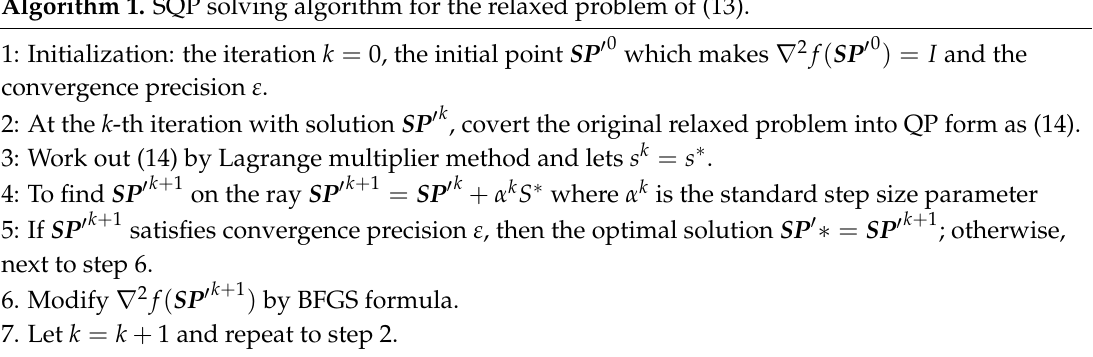
Algorithm 1. SQP solving algorithm for the relaxed problem of (13).